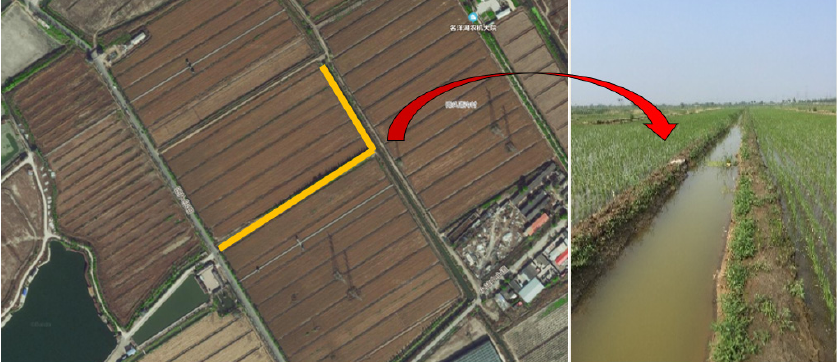
Figure 1. The location of the ditch and its prototype.